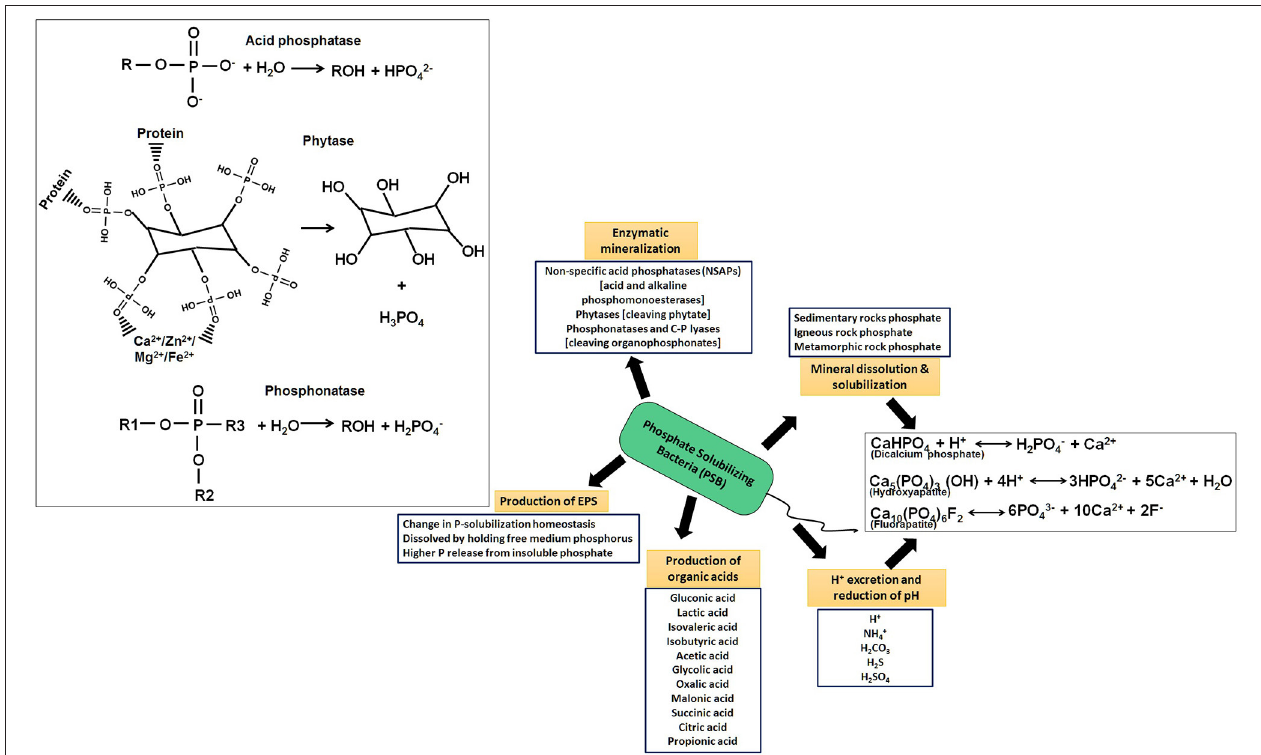
FIGURE 6 | Various mechanistic aspects of phosphate solubilizing bacteria (PSB) showing important routes of solubilization of rock phosphate and organic phosphate for its metabolism as well as uptake by plant as plant growth beneficial traits.